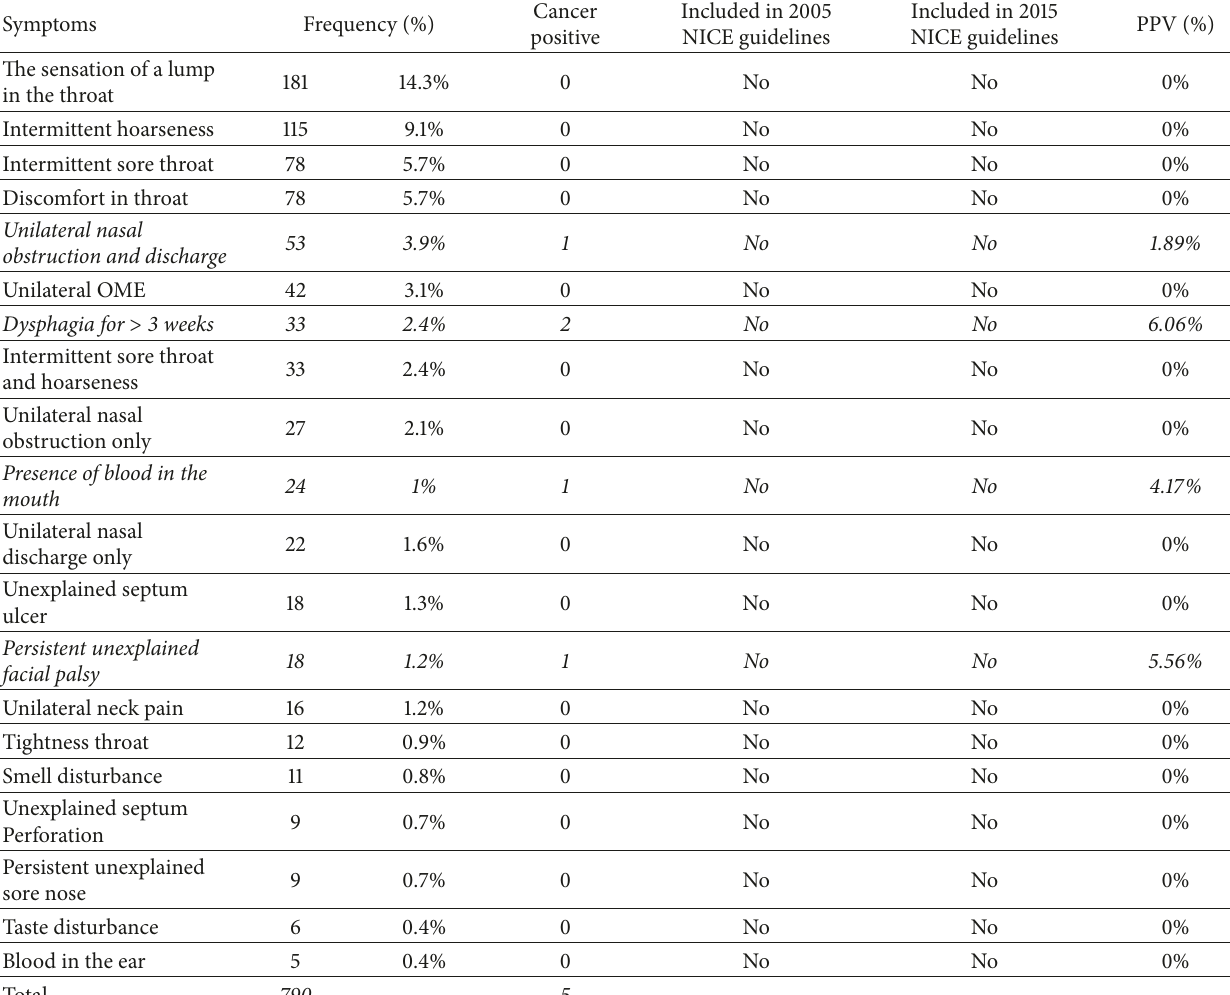
Table 3: Cancer detection rate in a patient referred through 2 ww pathway and NOT compliant with NICE guidelines.